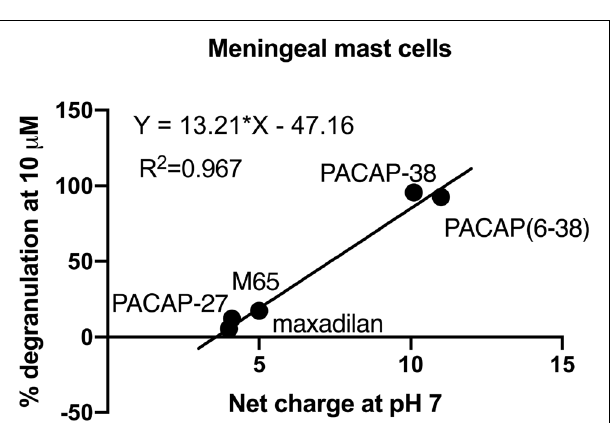
FIGURE 7 | A correlation of 0.967 is obtained between the mean amount of degranulation induced by five PACAP isoforms (PACAP-38, PACAP-27, PACAP(6–38), maxadilan and M65), n = 5–11 in meningeal mast cells and their net charge at neutral pH. Calculations are performed using the Bachem Peptide Calculator (http://www.bachem.com/service-support/peptide-